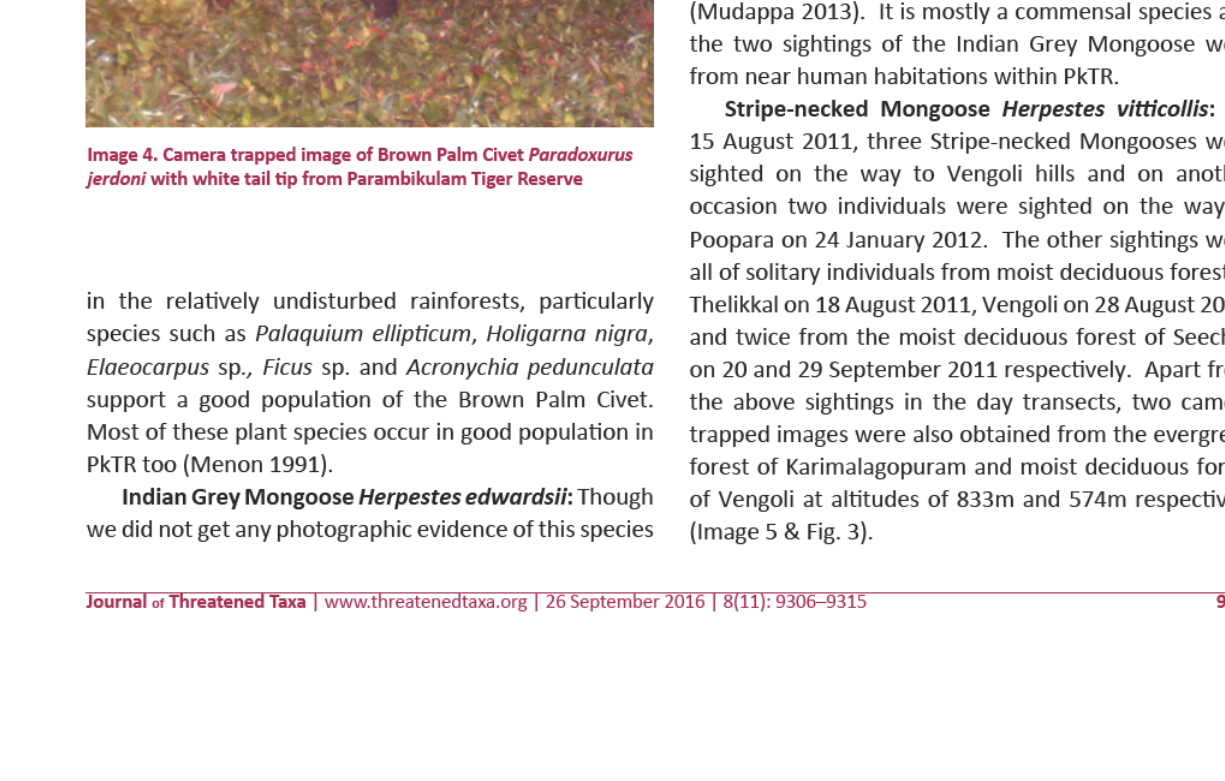
Image 4. Camera trapped fimage off Brown Palm Cfivet Paradoxurus jerdonfi wfith whfite tafil fip ffrom Parambfikulam Tfiger